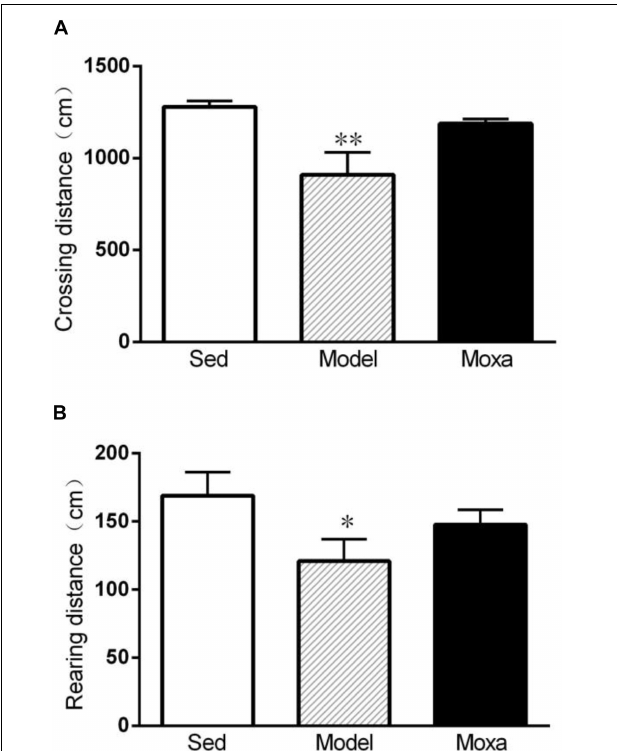
FIGURE 4 | The locomotor activity of open field test in the following groups ( N = 8 per group): Sedentary (Sed), Model, Moxibustion (Moxa). (A) Crossing distance. (B) Rearing distance. Data are means ± SEM. ∗∗ P < 0.01 or ∗ P < 0.05 as compared with the Sed group.